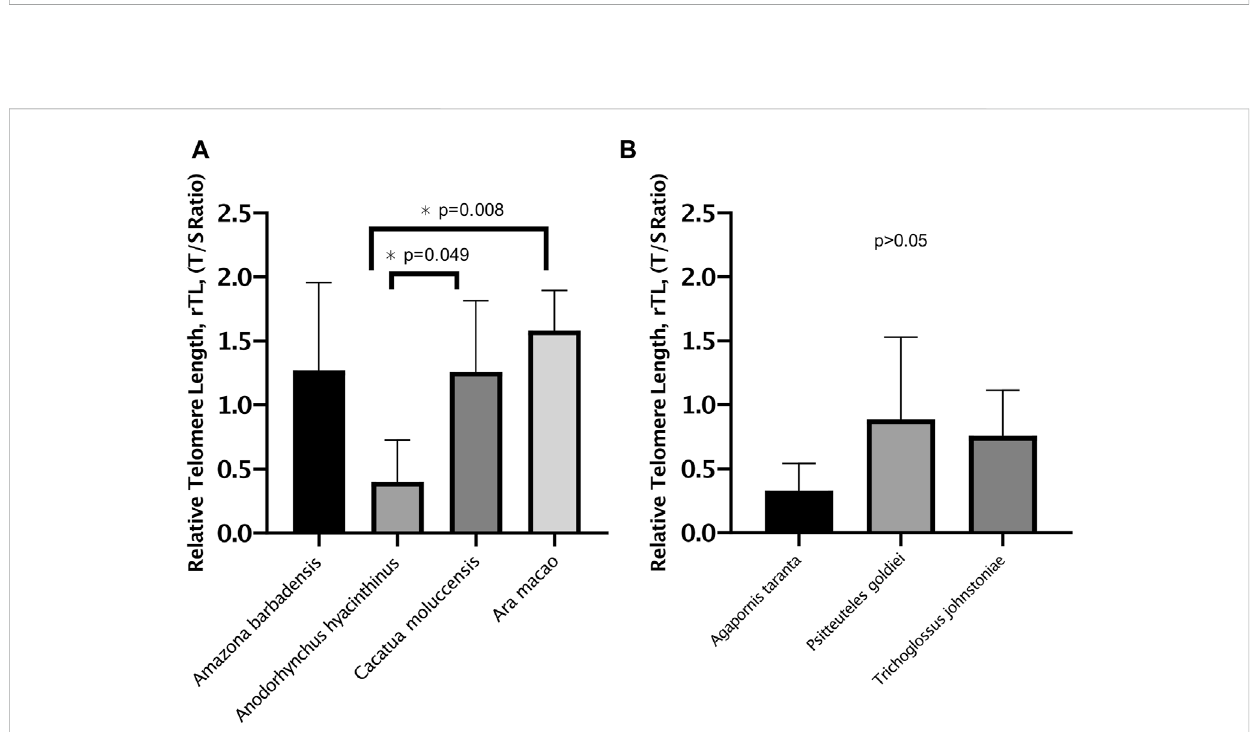
FIGURE 2 Relative telomere length (rTL) of Psittacidae species. (A) rTL (mean ± SD) of long-lived species. (B) rTL (mean ± SD) of short-lived species. Assessed by one-way ANCOVA controlling for standardized age.